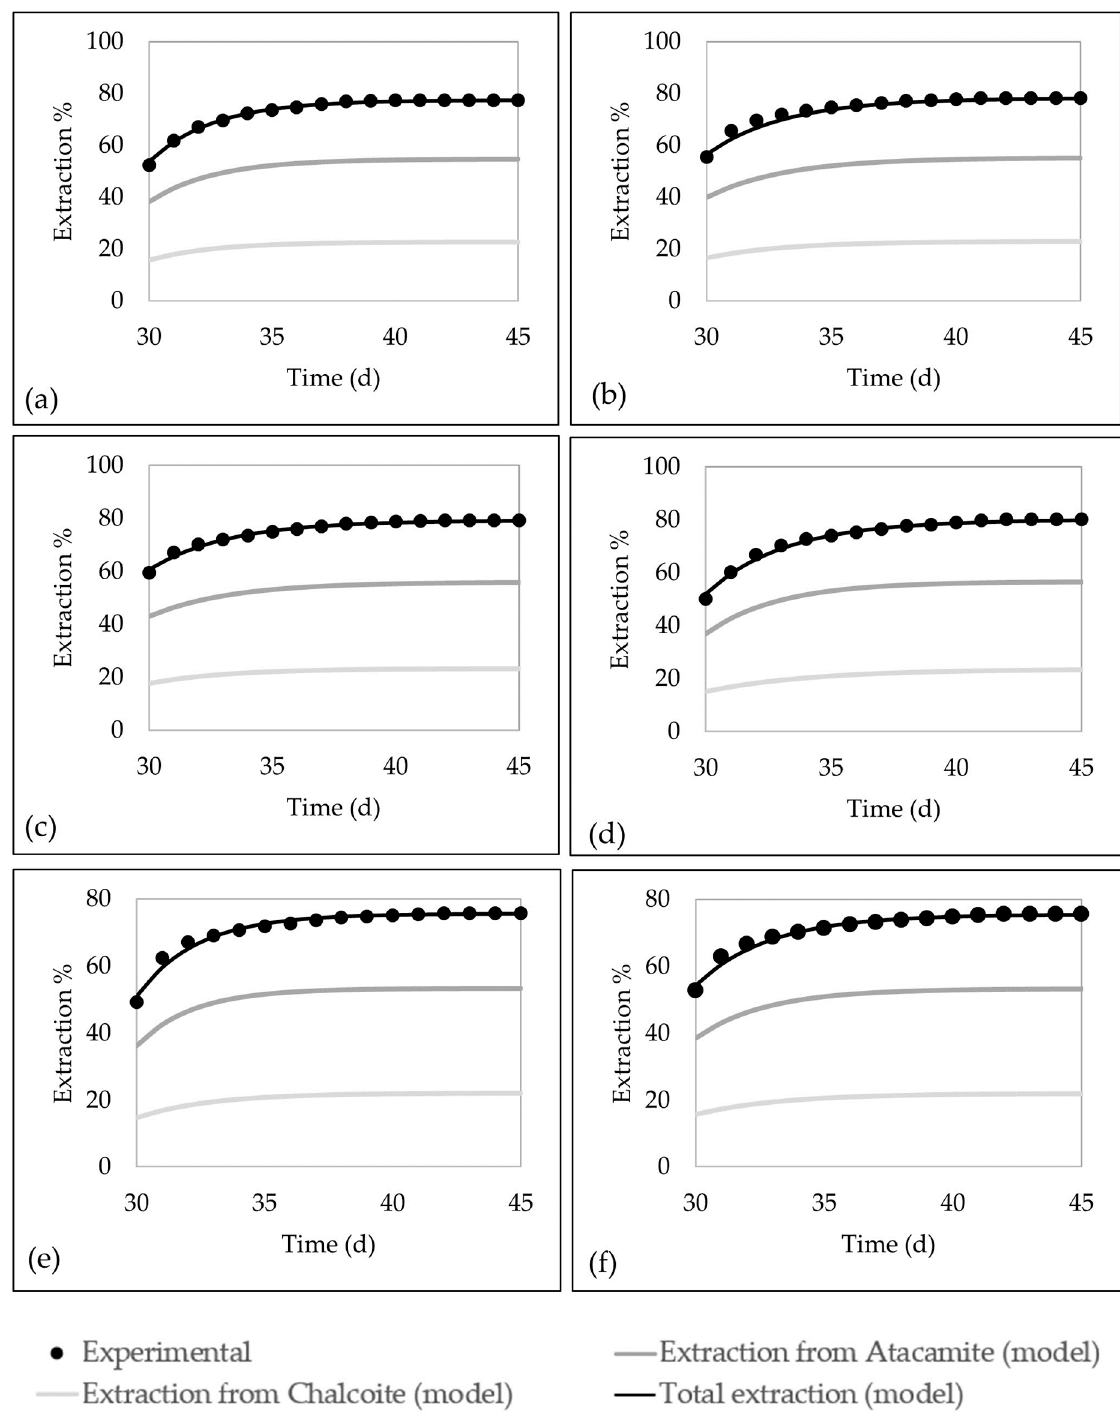
Figure 8. Comparison between experimental copper extraction and model adjustment for columns of tests C. ( a ) Test